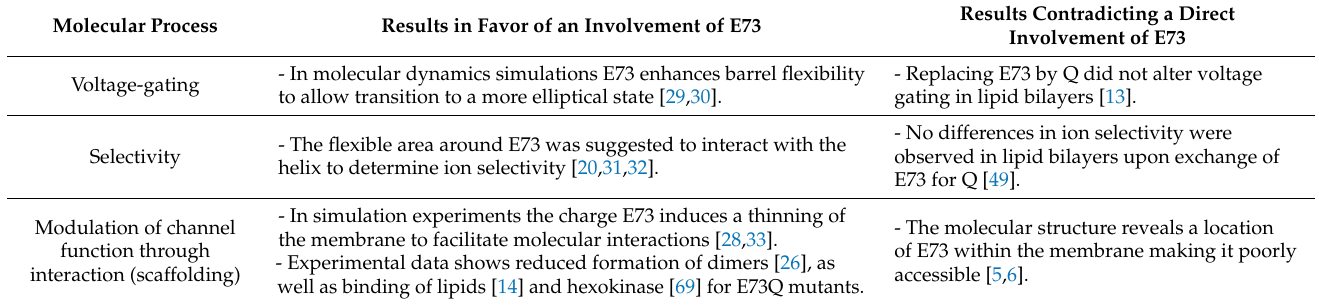
Table 1. The role of E73 for VDAC channel functions. The passage of ions and small metabolites though VDACs is regulated by channel gating, selectivity of the pore and interaction with molec- ular partners. E73 was repeatedly suggested to be critically involved in these processes. A direct comparison of key experimental results is presented.